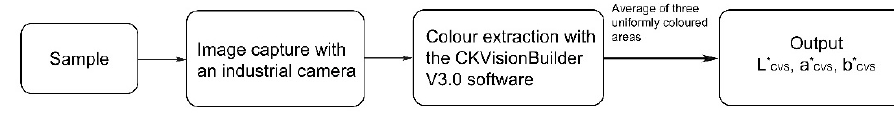
Figure 2. Schematic diagram of a CVS operation